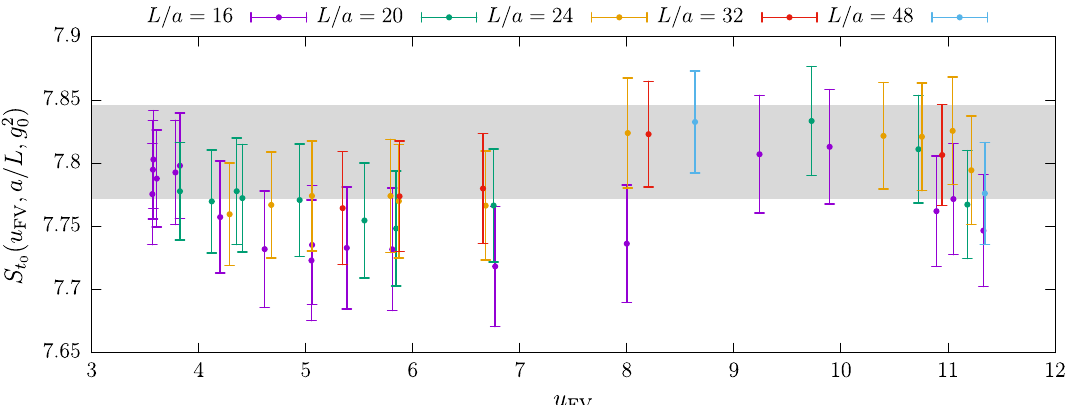
√ 8 t 0 μ ref up to